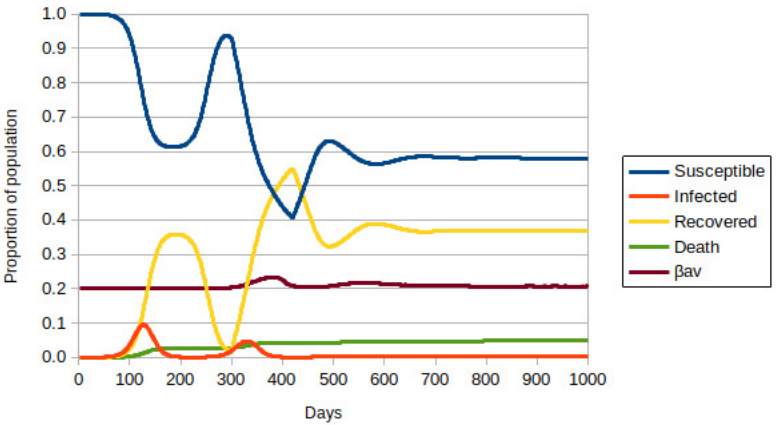
Figure 4. ABM-SIR dynamic of COVID-19 (i.e., Susceptible-Infected-Recovered Agent-Based model) evolution over 1000 days for social isolation of 40%, adjusted for the initial population of ∼ 8.75 × 10 5 individuals. Each color represents a population group, defined in the legend. The value of β av is the average for all infected people. The vaccination rate is 1/200 of susceptible or recovered individuals per day.